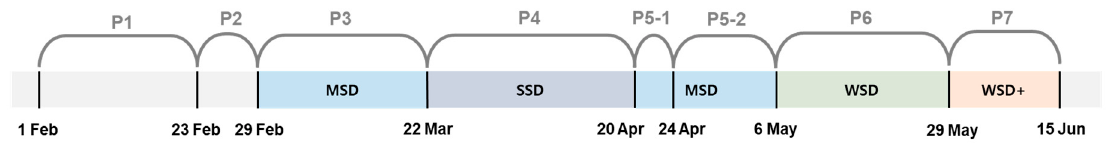
Figure 2. Timeline of social distancing and control interventions. Periods 1–7 are denoted by P1–P7, respectively.